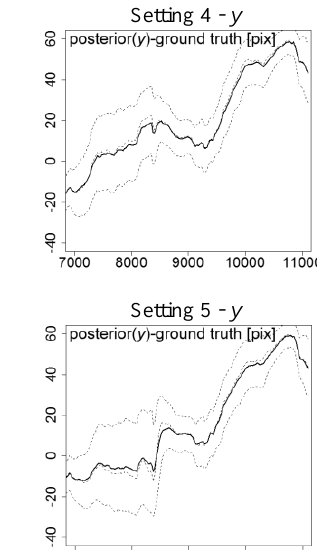
Figure 6. Posterior distributions of positions in each